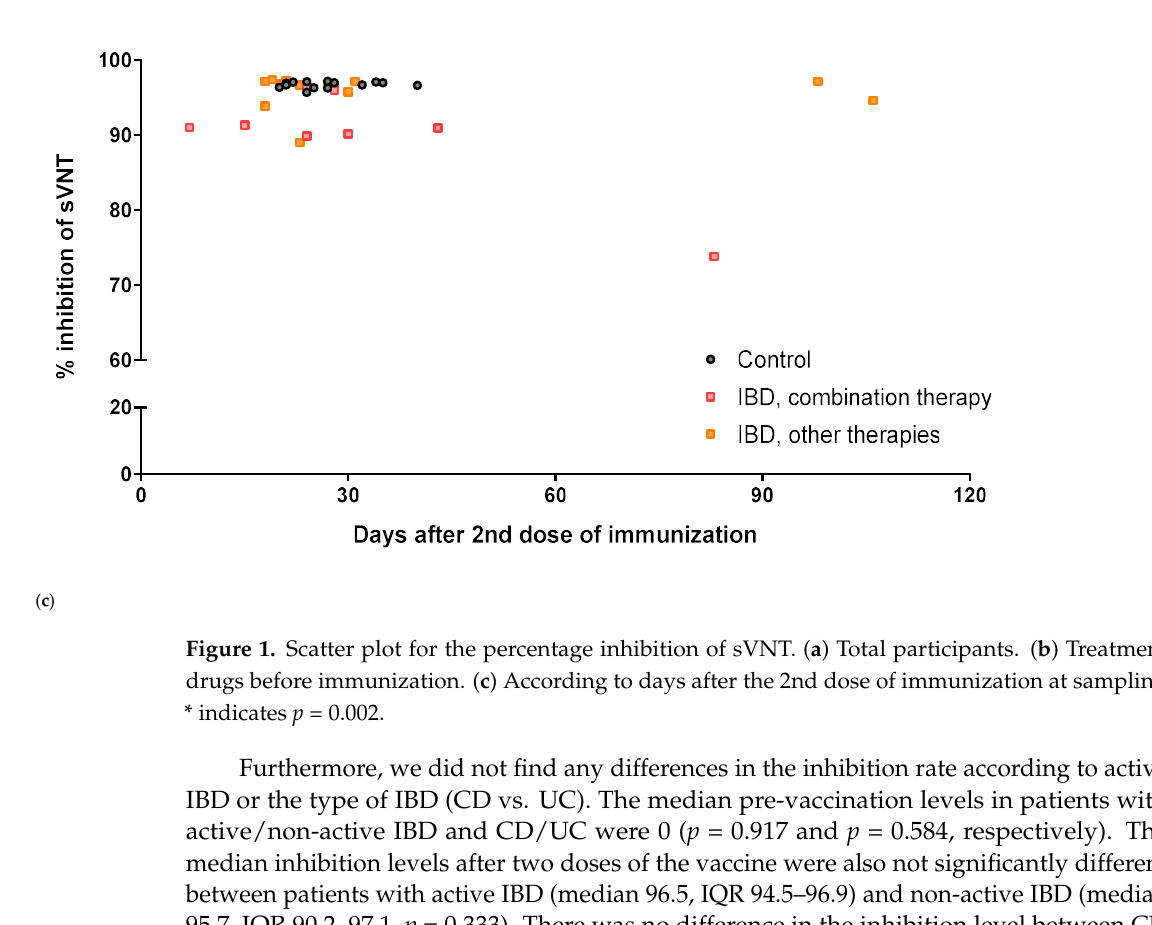
Table 2. Frequency of adverse events after each dose.